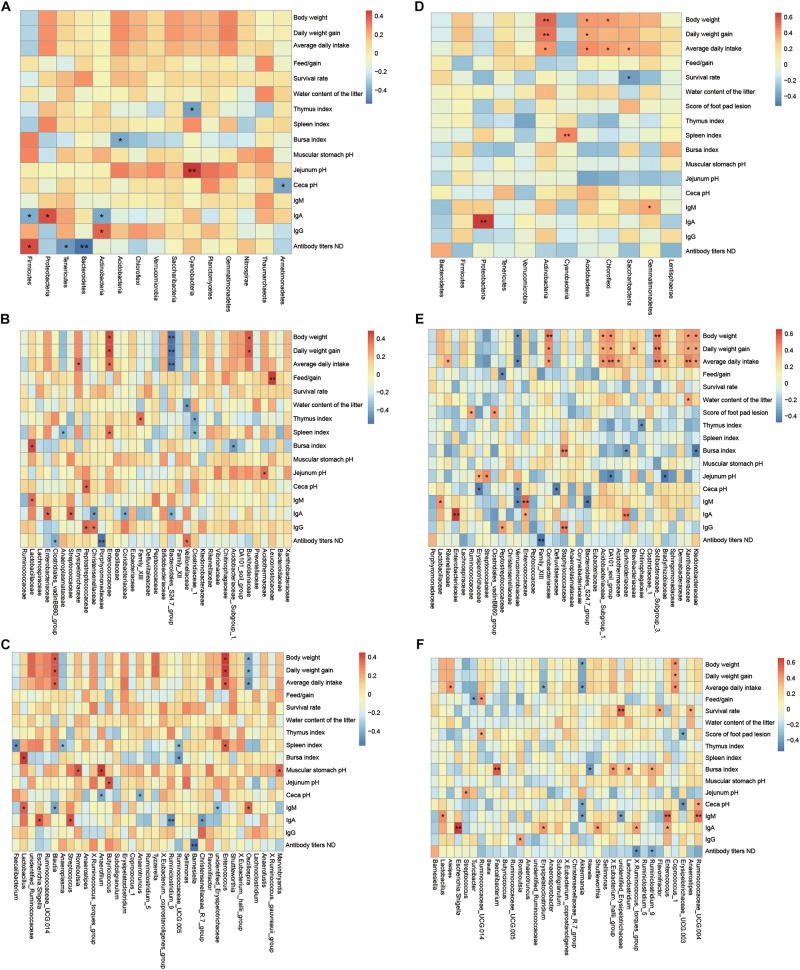
Correlation between the most abundant taxa of the cecal microbiota at the level of phylum, family, and genus and growth performance, gut chyme pH, tissue index, and serum immune response indices of broilers at the ages of 21 and 42 days. (A) Phylum at 21 days. (B) Family at 21 days. (C) Genus at 21 days. (D) Phylum at 42 days. (E) Family at 42 days. (F) Genus at 42 days. The values corresponding to the intermediate heat map are Spearman correlation coefficients r, which is between −1 and +1, negative correlation when r < 0, and positive correlation when r > 0; results of significance tests were P < 0.05 or P < 0.01 when marked ∗ or ∗∗, respectively. Only taxa that occupied more than 0.5% in at least one region at the phylum level or more than 3% at the family and genus level are presented.